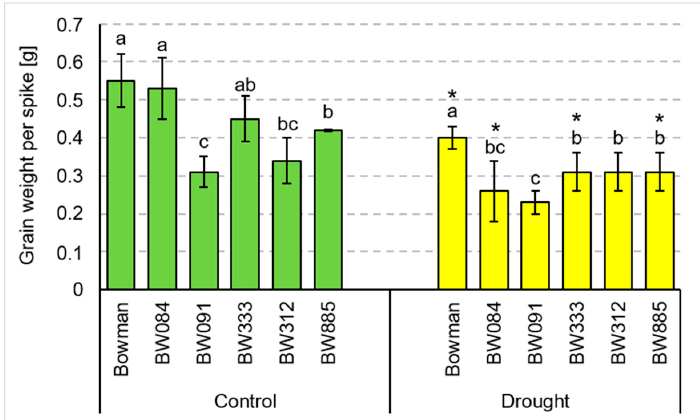
Figure 5. Average grain weight per spike of the analyzed genotypes under the optimal watering (control) conditions and after the drought stress (the pot experiment). The mean values ± (SD) marked with the same letters (separately for the control and drought-stressed plants) are not significantly different, according to Duncan’s test ( p ≤ 0.05). Asterisks denote significant difference in comparison of values reported in each genotype between the control and drought conditions according to Student’s t -test. Details are given in the text.